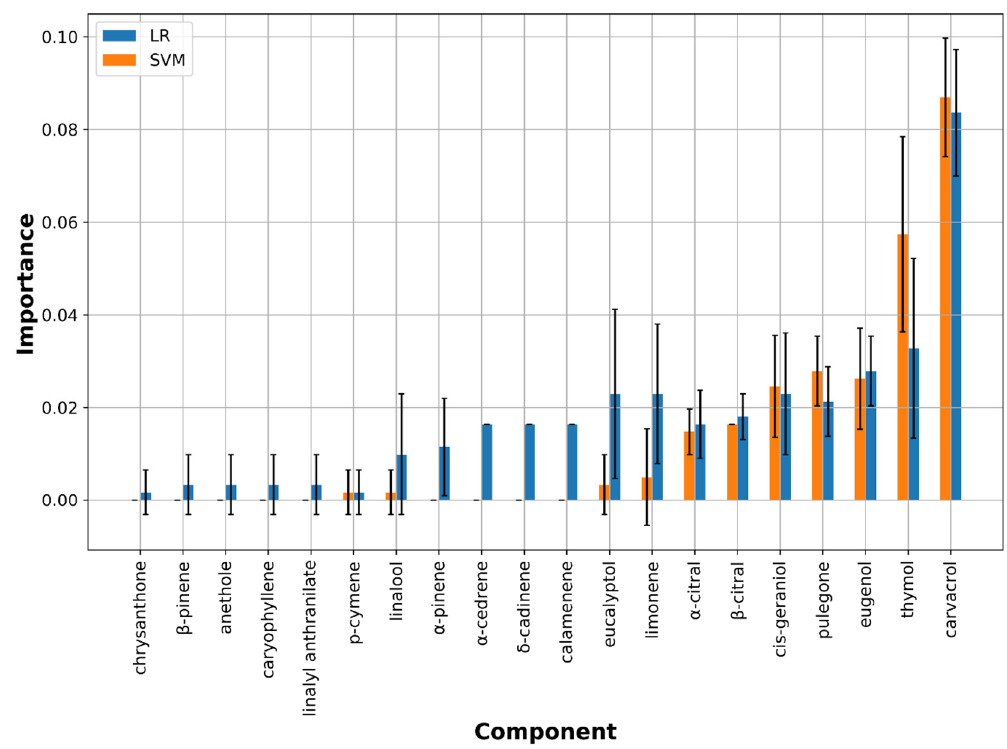
Figure 4. Perturbation-based feature importance for the LR (blue bars) and SVM (orange bars) ML-based models on M. gypseum reported using mean and standard deviation. Only the first 20 most important compounds are listed.